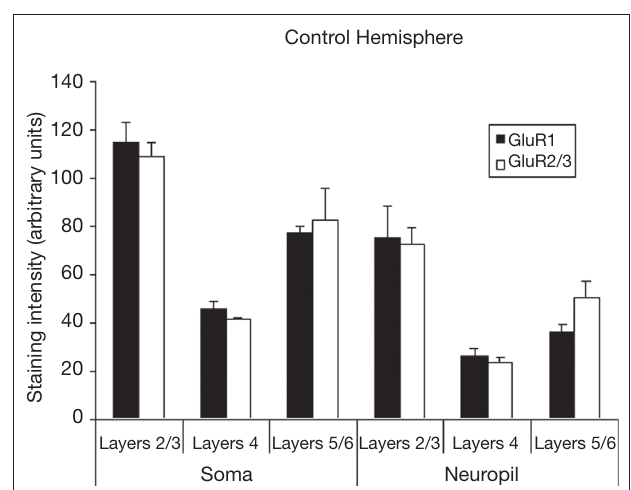
FIGURE 2 | Average staining intensity for GluR1 and GluR2/3 AMPA receptor subunits in the median nerve area of the control hemispheres. Data are grouped by layer(s) (2/3, 4, and 5/6), and by whether the intensity measurements were taken from cell bodies or from neuropil. Staining intensities for GluR1 and GluR2/3 are higher for measurements taken from cell bodies than for measurements taken from neuropil. For both GluR1 and GluR2/3 staining intensities are highest in upper layers of cortex, with weaker staining in layer 4, and more moderate staining throughout layer